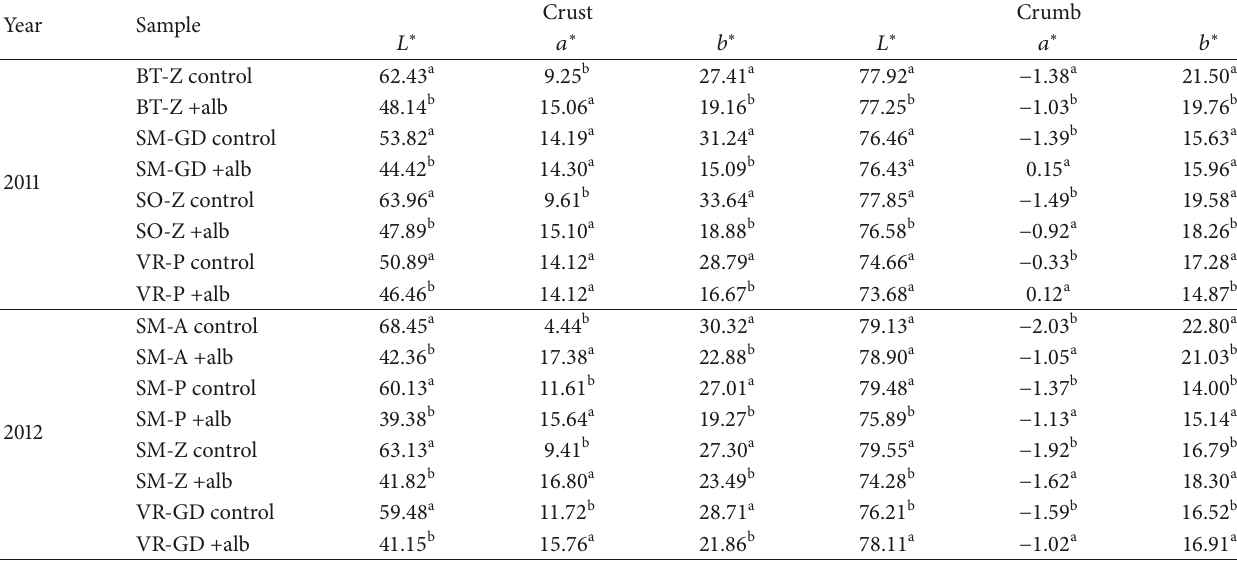
Table 1: The crust and crumb colour of control bread and bread enriched with